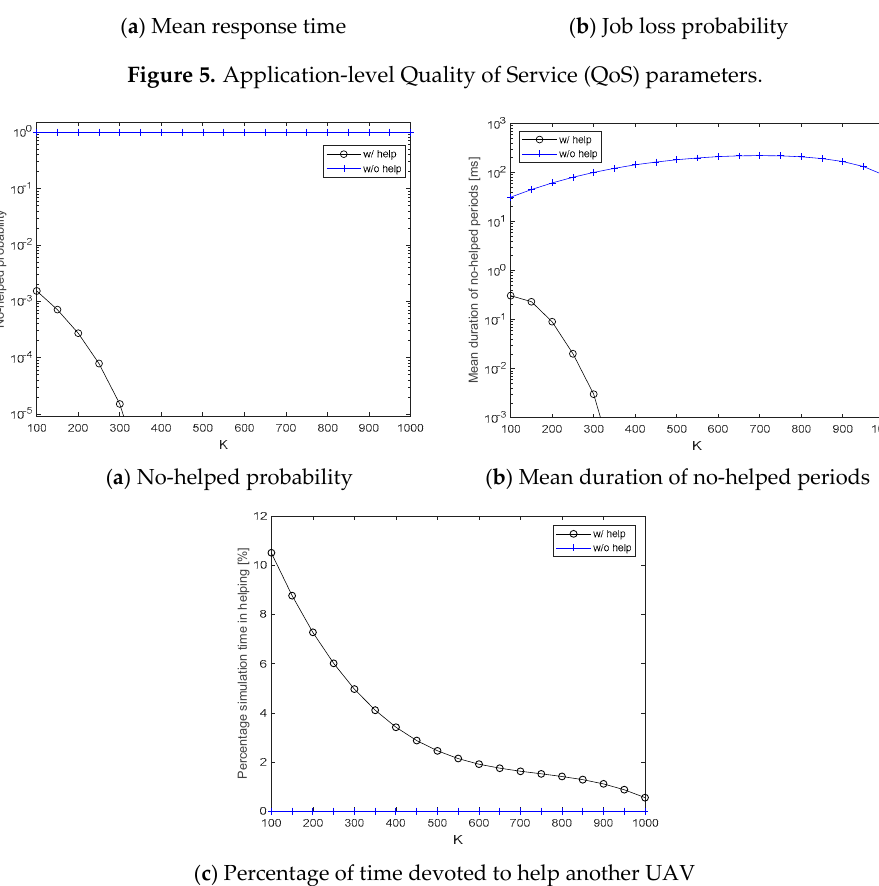
Figure 6. Performance parameters for a behavior analysis of the proposed framework.